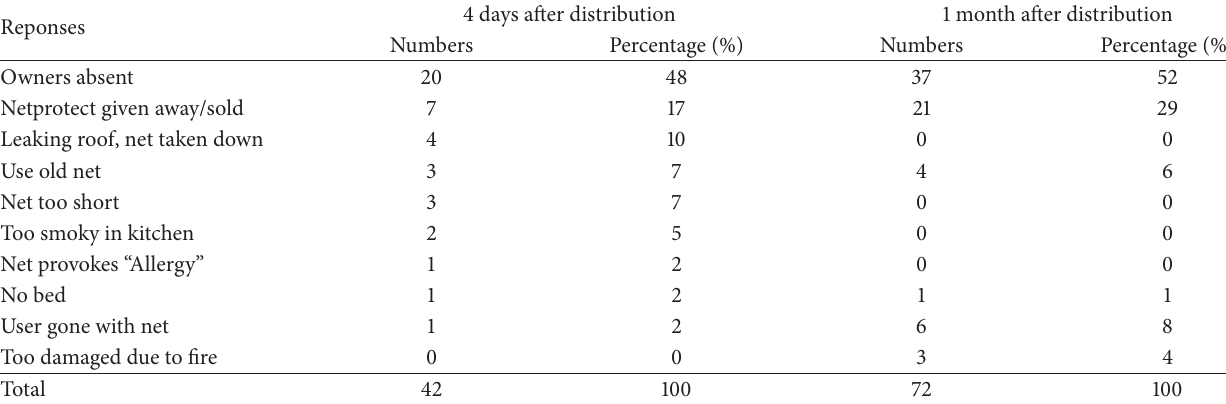
Table 6: Reasons for nets not found